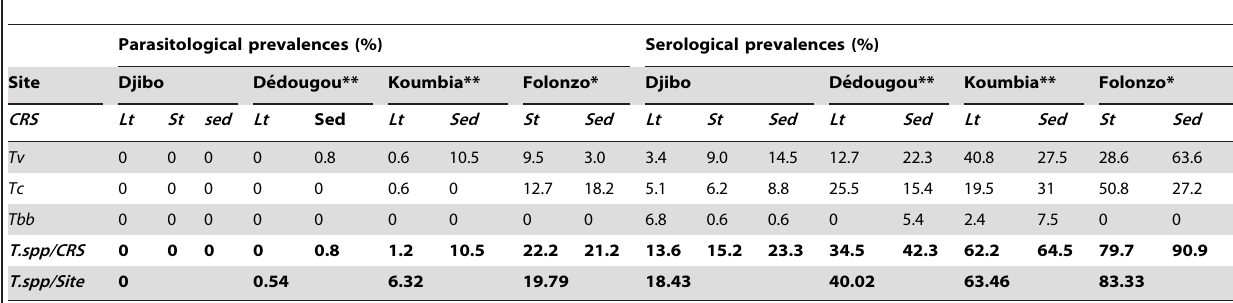
Table 2. Parasitological and serological prevalences by trypanosome species according to cattle rearing systems and sites.